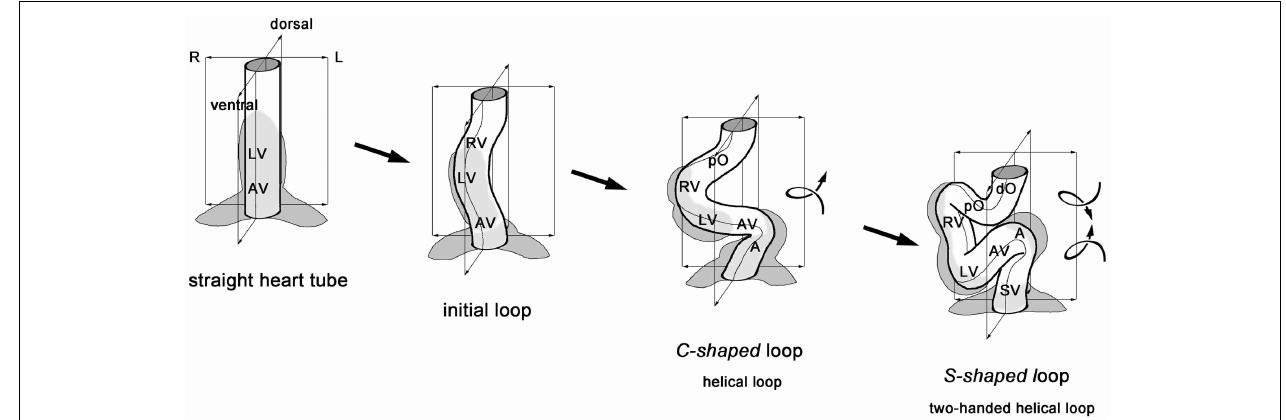
FIGURE 1 | This schematic drawing illustrates the sequence of idealized geometrical form changes characterizing the looping morphogenesis of the tubular heart of higher vertebrate embryos. During the initial phase of looping, the straight tube starts bending along the mid-sagittal plane toward the ventral body wall. Rightward torsion deforms the bending tube into a helically coiled loop with a counter-clockwise winding (“C-shaped” loop). The